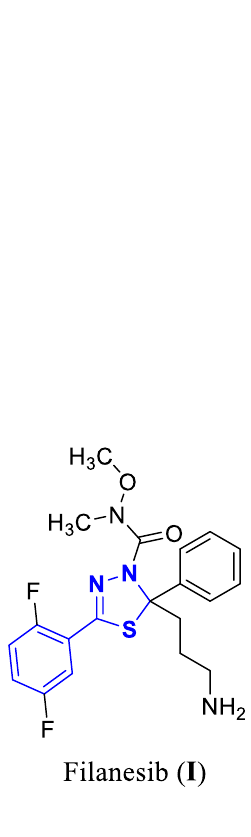
Figure 1. Structures of 1,3,4-thiadiazole derivatives ( I – III) with anticancer